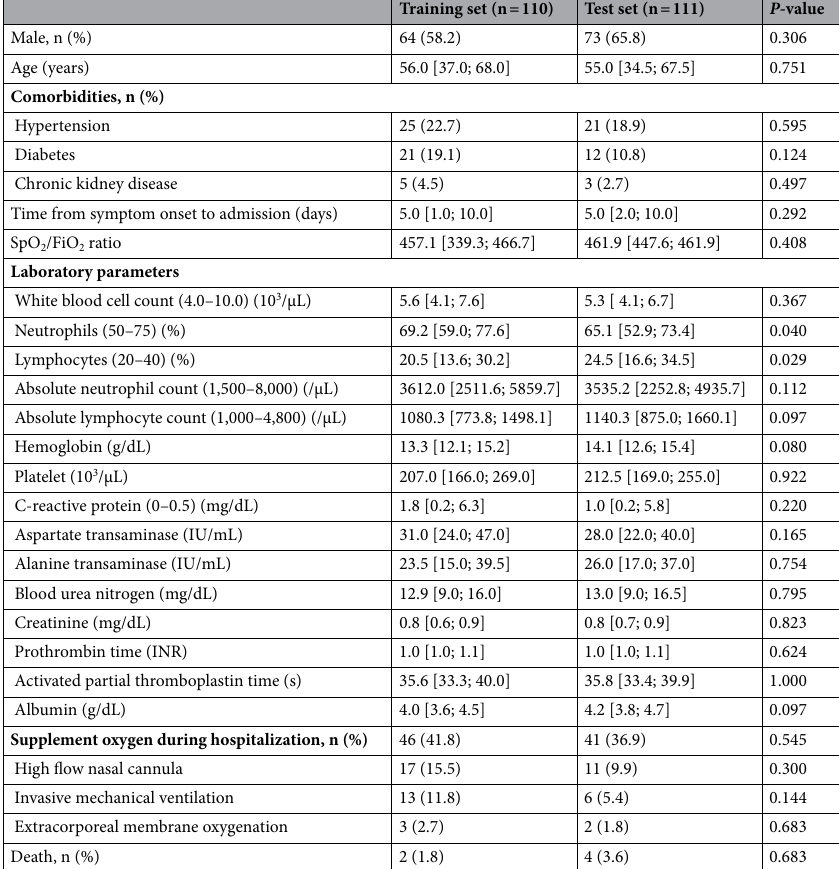
Table 1. Clinical characteristics of the patients in the cohort. Normally distributed values are expressed as the mean (standard deviation), and non-normally distributed values are expressed as the median [interquartile